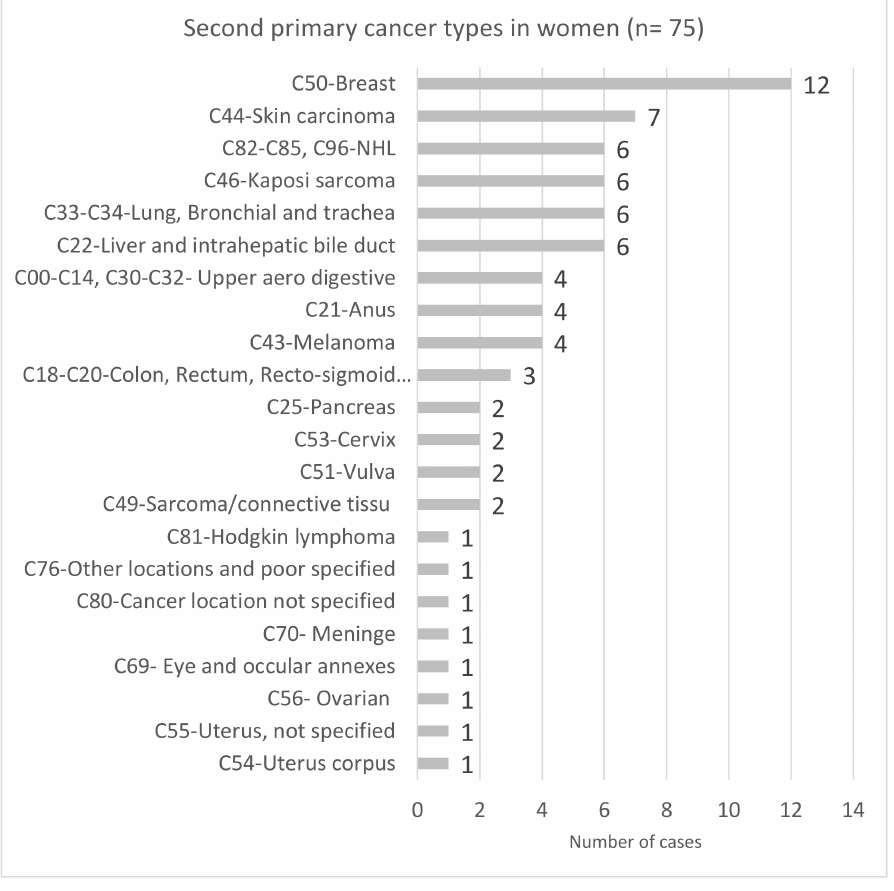
Figure 1. Spectrum of second primary cancer types in women living with HIV in the French Dat’AIDS cohort ( n = 75). Abbreviation: NHL: non-Hodgkin